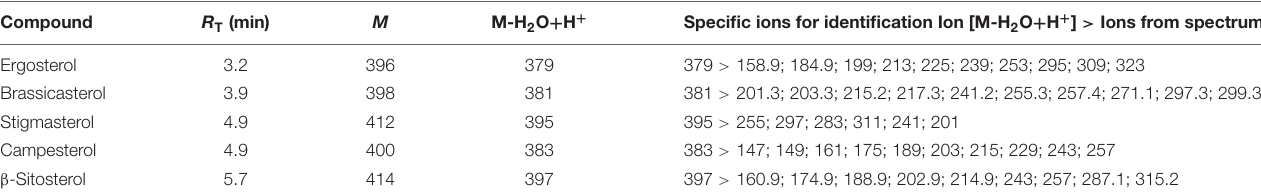
TABLE 3 | Characteristic ions of standard sterols in full scan mode by LC-MS/MS. Compound